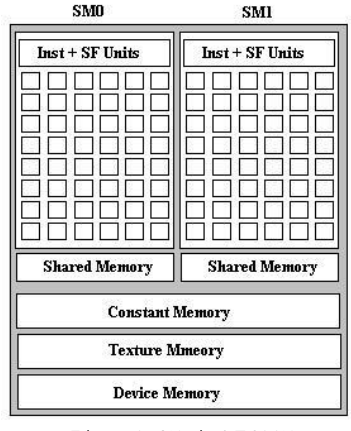
Figure 4. Structure of CNN (Ciresan et al.